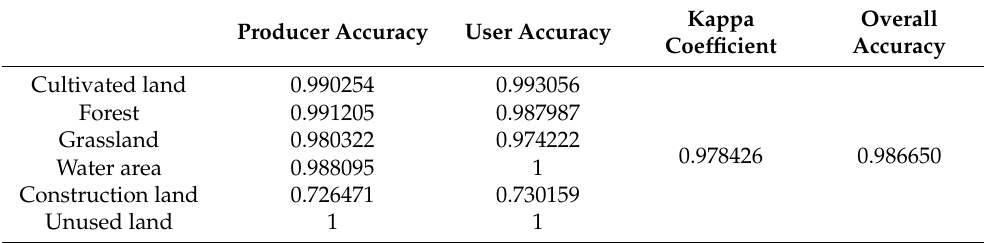
Figure 5. Real state and modeling results of land use types in 2000. ( a ) Real status ( b ) Simulation results. Table 2. Simulation accuracy of the FLUS model in a no policy context.